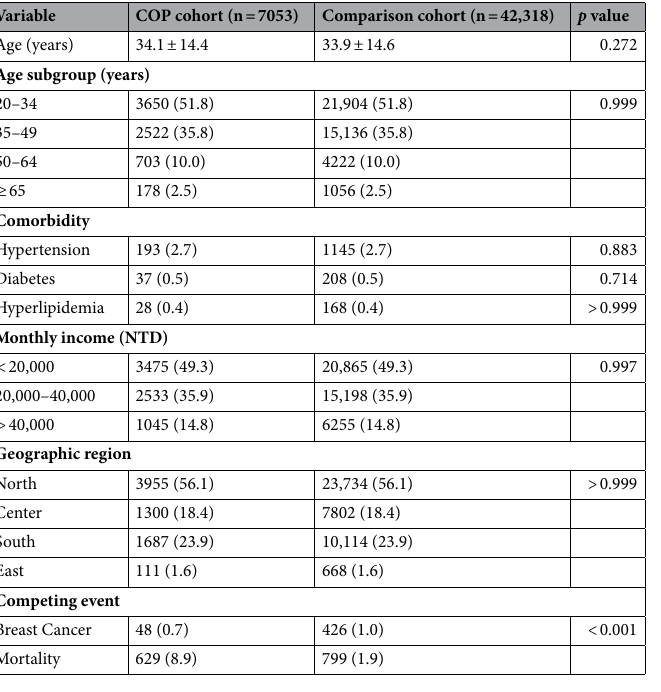
Table 1. Age, comorbidities, monthly income, and geographic area of residence of COP and comparison cohorts. COP carbon monoxide poisoning, NTD New Taiwan dollars. Data are expressed as mean ± standard deviation or n